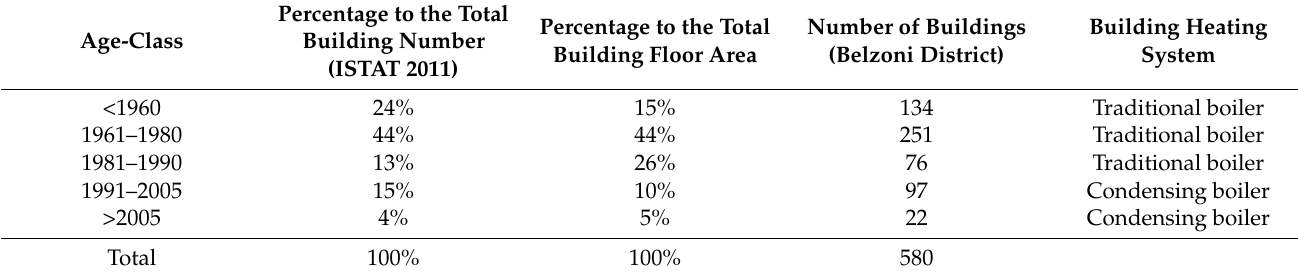
Table 1. Age-classes percentage distribution of the Padua municipality and number of buildings.